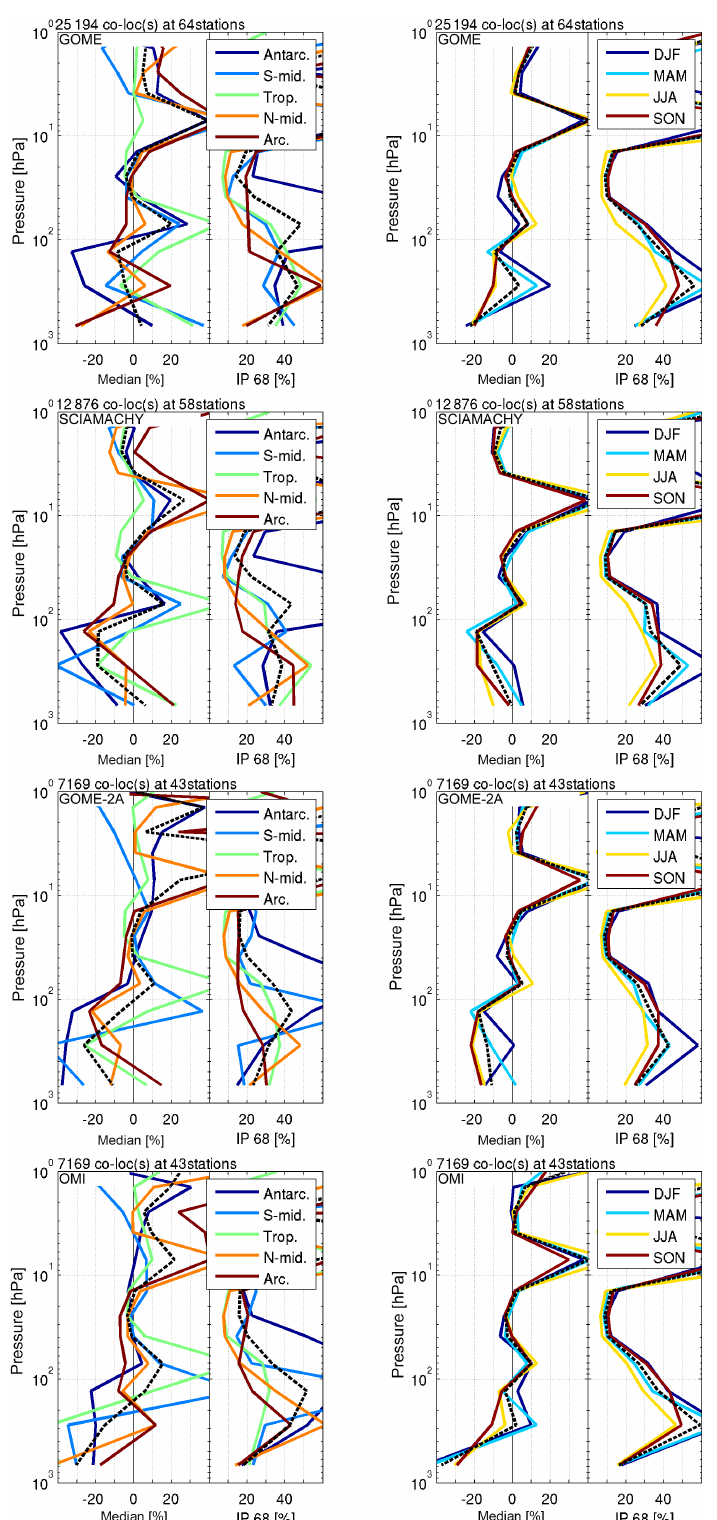
Figure 11. Median relative differences and 68% interpercentile spreads for comparison of L3 GOME, SCIAMACHY, GOME-2A, and OMI data (top to bottom panels) with ground-based reference measurements. The same difference statistics are redistributed in each line over two influence quantity ranges, with the influence quantities being the latitude (left panels) and quarter (right panels). The black dashed line shows the average of the coloured